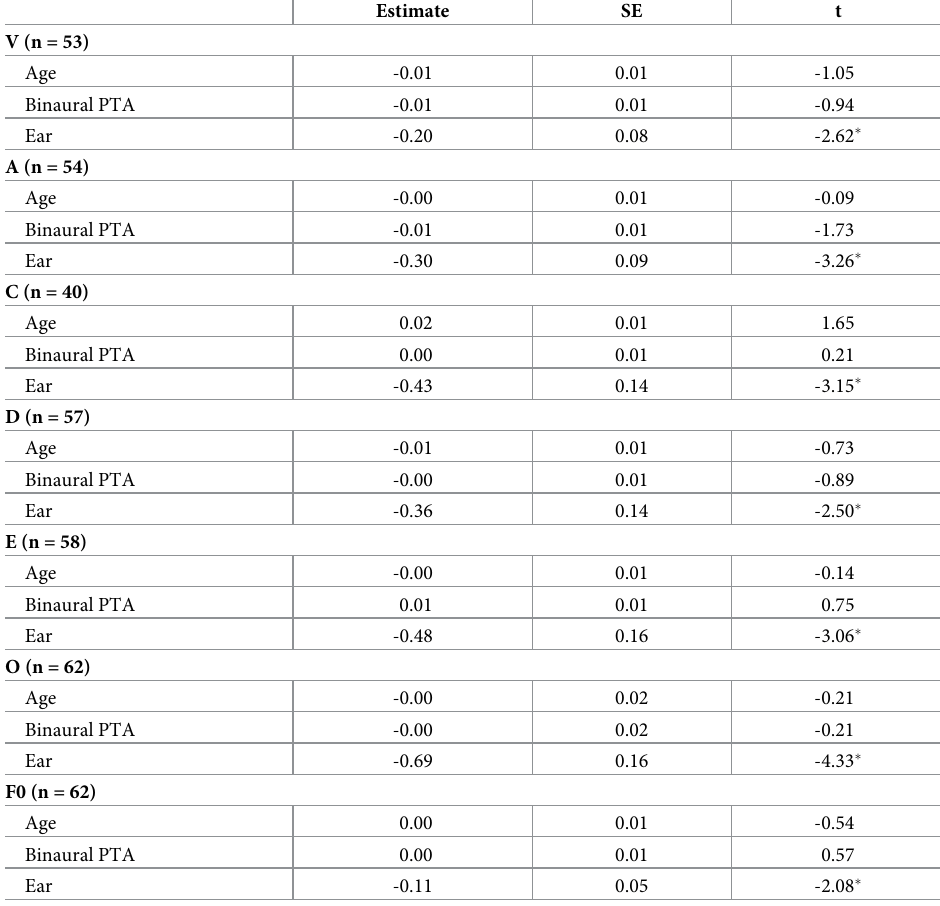
Table 4. Mixed effects results for all inspected speech-ABR components.